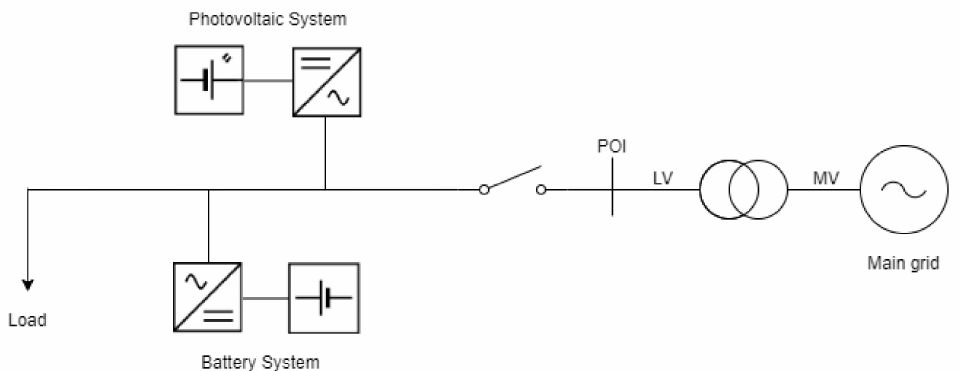
Figure 1. General microgrid schematic illustrating the interconnected (switch closed) and islanded (switch opened) operation modes. POI—point of interconnection; LV—low voltage; MV—medium